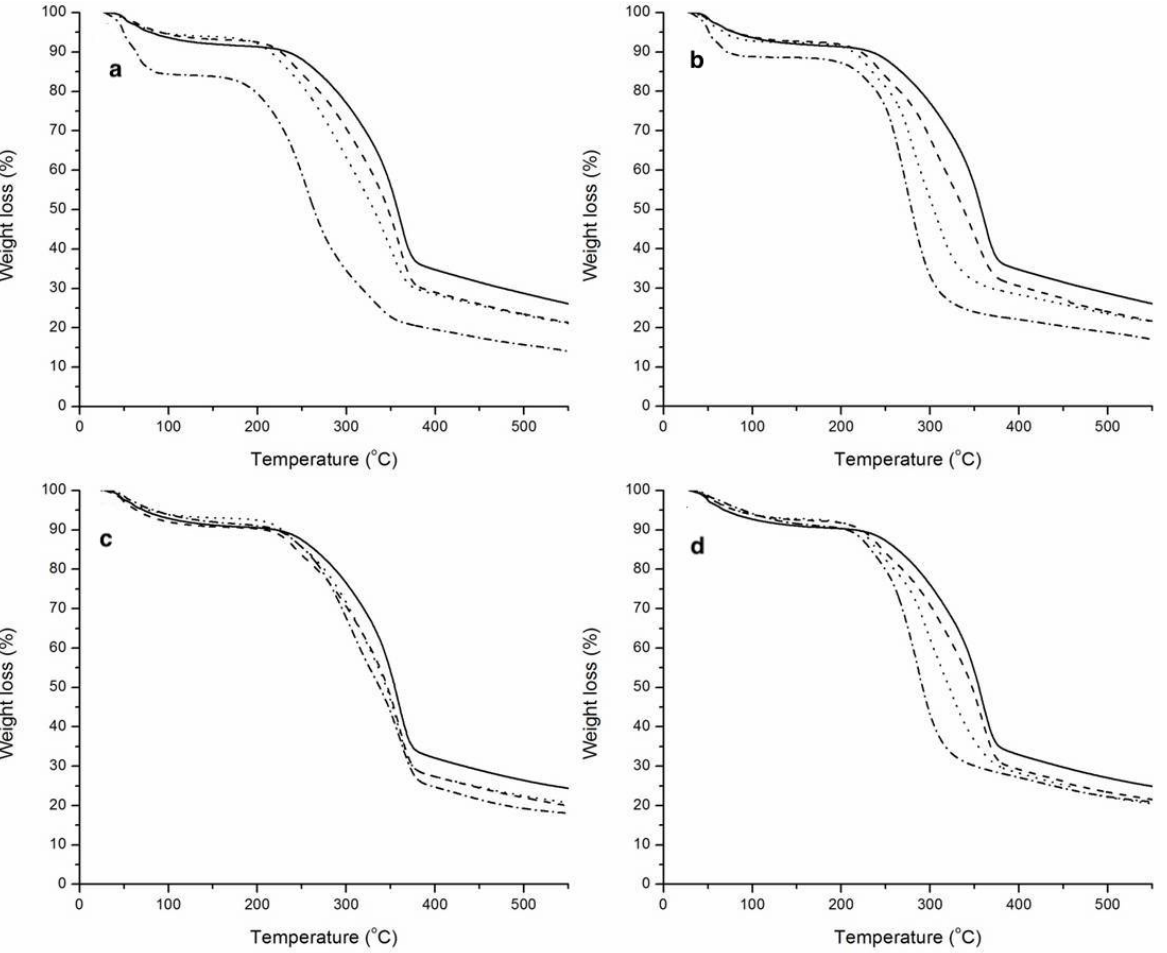
Figure 1. TGA thermograms of soybean hull treated with [bmim][Ac] ( a and c ), and [bmim][Cl] ( b and d ), for 2 h ( a and b ), and 6 h ( c and d ). Legend: (—) untreated biomass, (----) IL 50 % and 75 °C, (. . . .) IL 100 % and 75 °C, and (-.-.-.) IL 100 % and 100